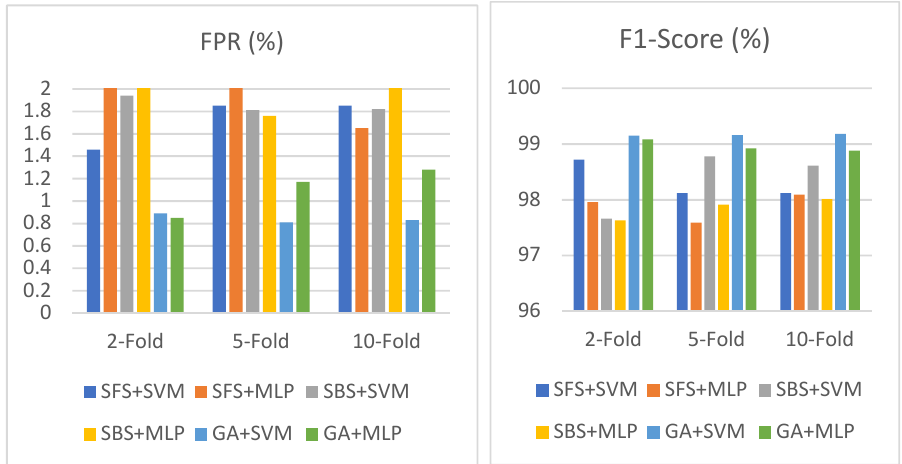
Figure 9. Performance of SFS, SBS, and GA using objective function based on DR, FPR, and number of selected features in NSL-KDD.